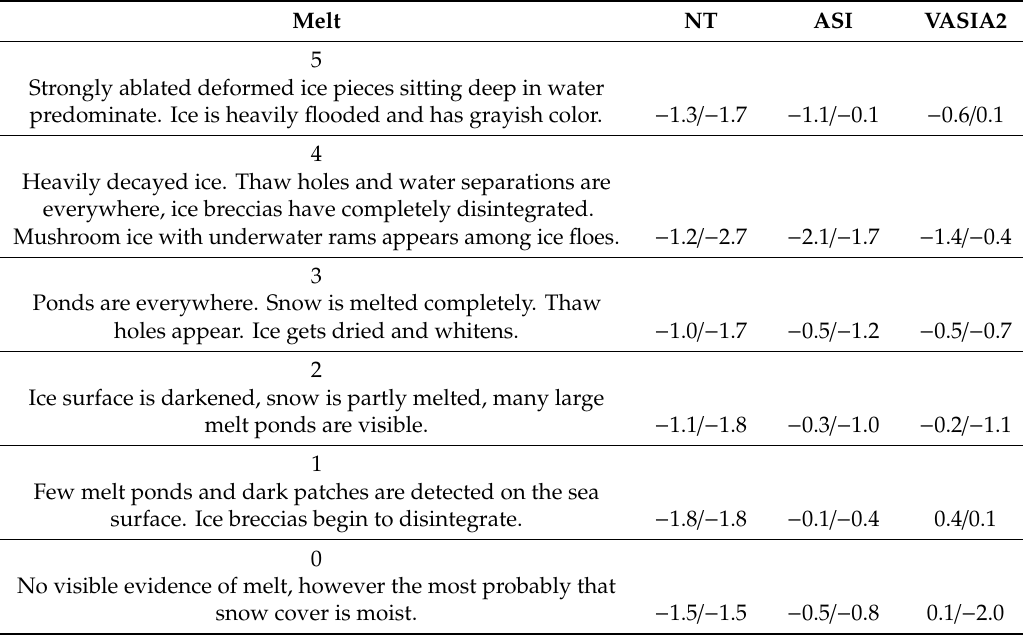
Table 3. Average errors of C smr against C so (tenths) at di ff erent ice melt stages (points) calculated